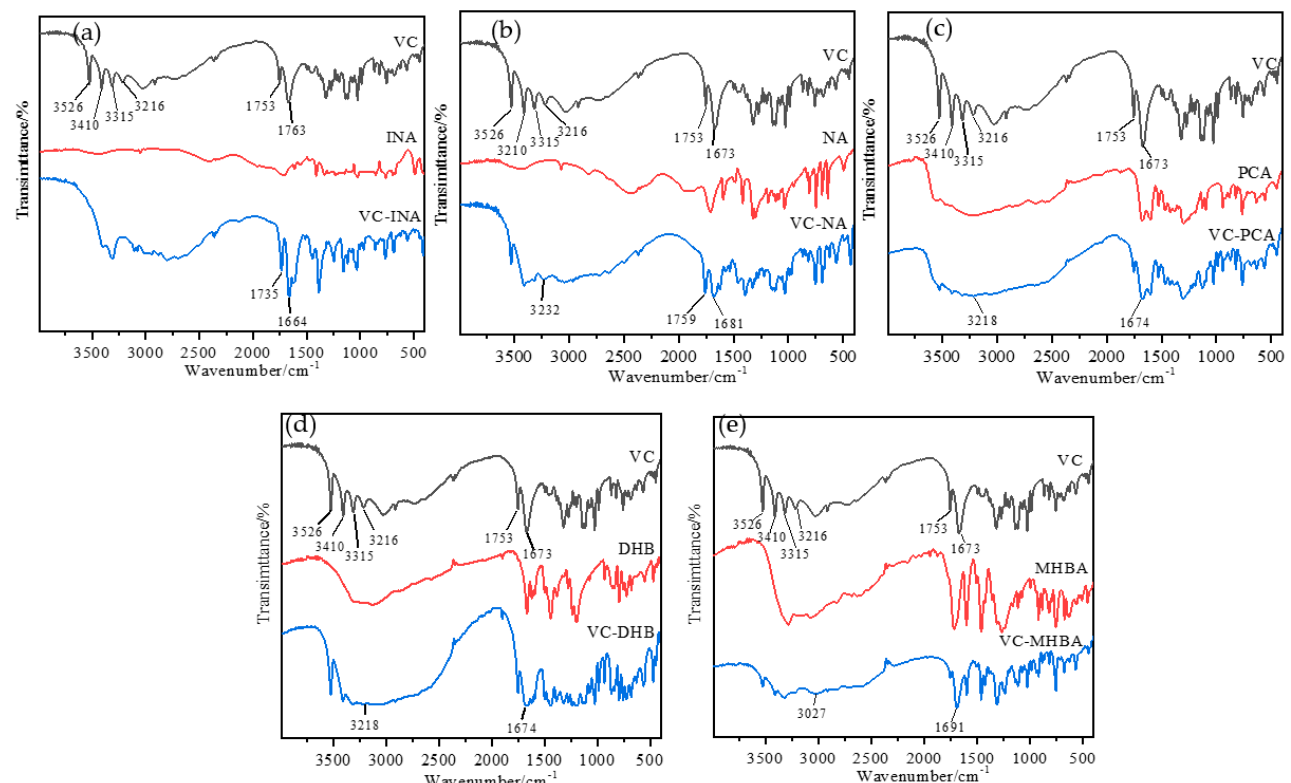
Figure 5. FT-IR analysis plots of ( a ): VC-INA; ( b ): VC-PCA; ( c ): VC-NA; ( d ): VC-DHB; ( e ): VC-MHBA.